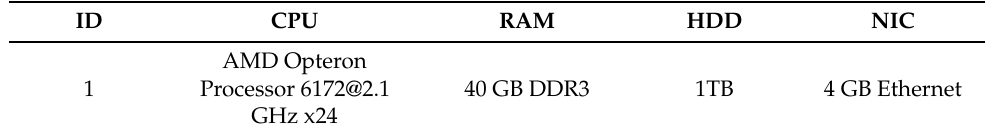
Table 2. System Service Equipment.